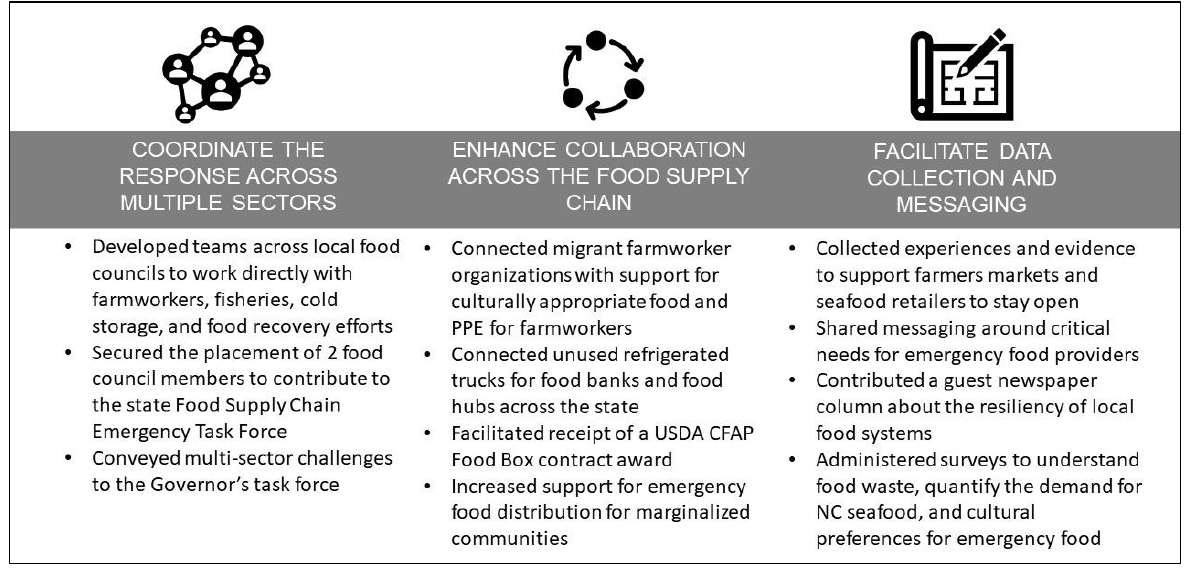
Figure 1. Key Areas of Action for the North Carolina Local Food Council’s Response During the COVID-19